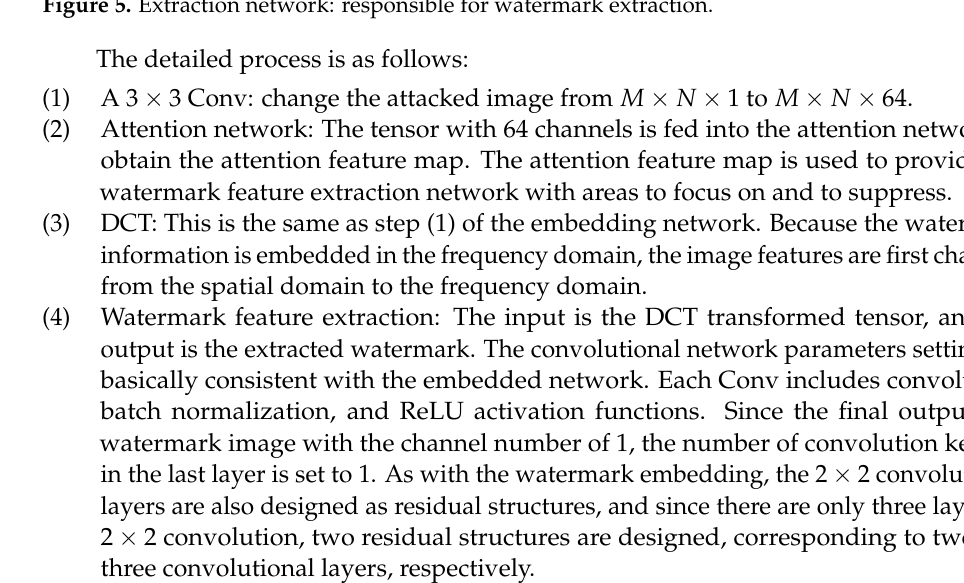
Figure 5. Extraction network: responsible for watermark